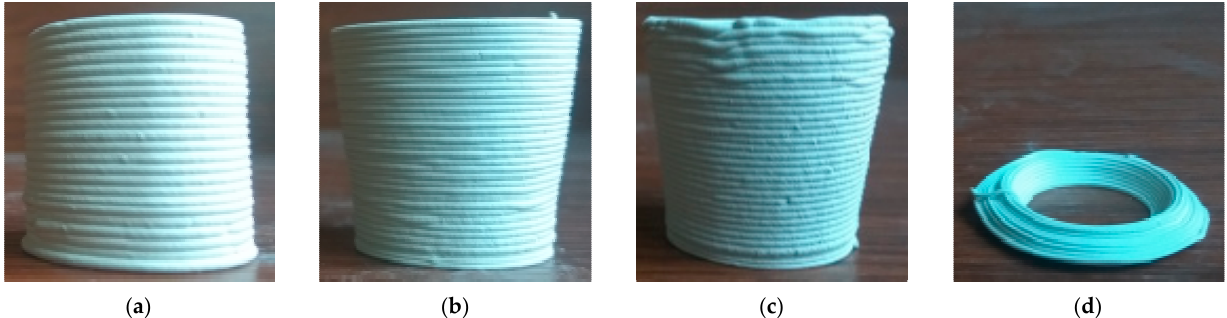
Figure 3. Conical thin-walled benchmark parts with layer height as 0.8d: ( a ) cone angle 0 ◦ , ( b ) cone angle 10 ◦ , ( c ) cone angle 15 ◦ , and ( d ) cone angle 20 ◦ .